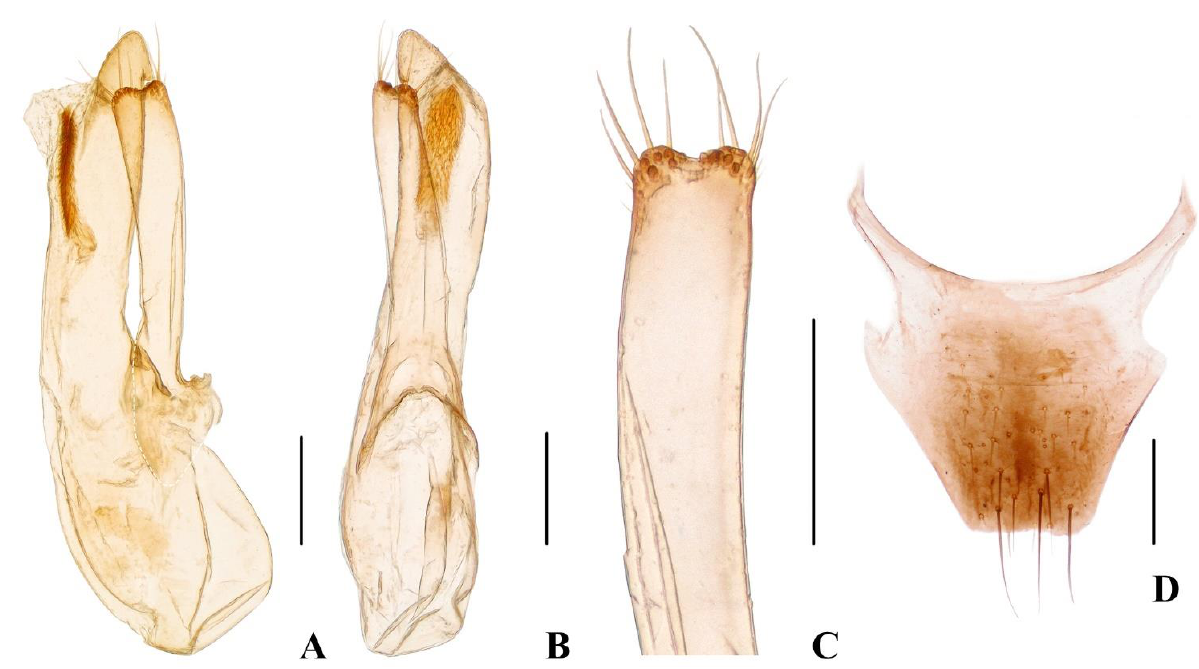
Figure 5. ( A – D ) Hesperoschema bii . ( A – C ) Aedeagus, lateral ( A ) and ventral ( B ) views; ( C ) paramere; ( D ) female abdominal tergite X. Scale bars = 0.2 mm.